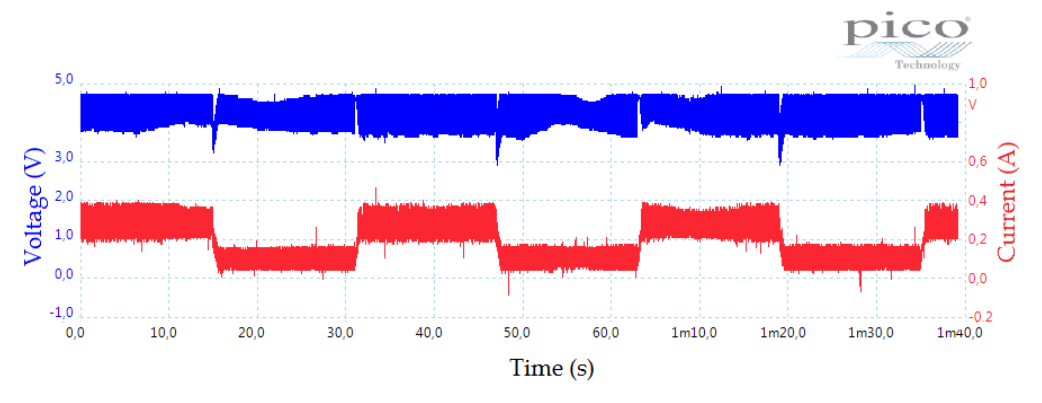
Figure 17. PV voltage and current time evolution by employing the hysteresis Maximum Power Point Tracking (MPPT) method.